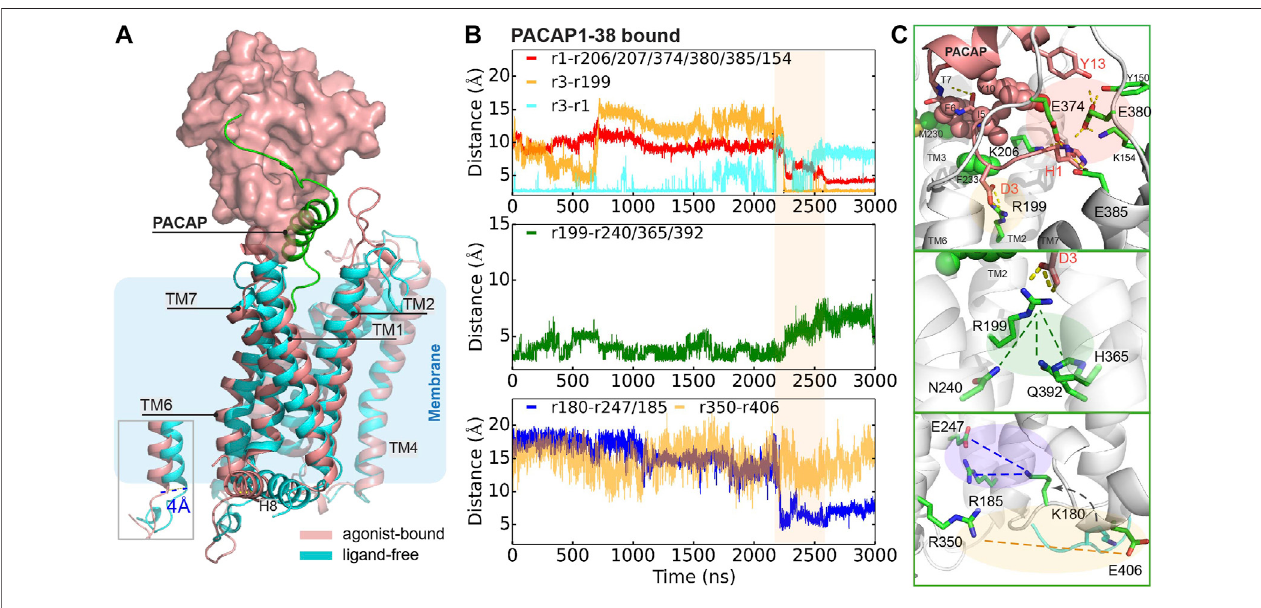
FIGURE 3 | Representative conformation of PACAP-activated PAC1null receptor. (A) Structural alignment of PACAP-activated (red) and ligand-free (cyan) conformations. Ligand-free conformation is from our recent study(Liao et al., 2017) with only the 7TM shown. PACAP is shown in green cartoon and ECD is shown in surface representation. (B) Time evolution of average distance or pair distance of key charged/polar residues locating at the extracellular side, middle transmembrane, and intracellular side of the PAC1null receptor, which are displayed in (C) accordingly. Adaptive tempering period is in light orange strip